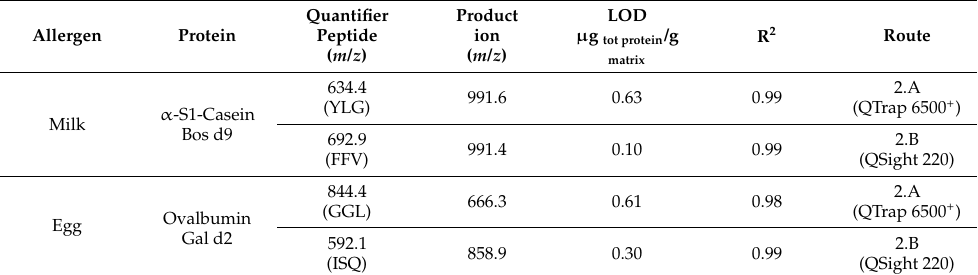
Table 3. Results of MRM experiments referred to matrix-matched calibration curves produced in fortified biscuits (route 2.A and route 2B) employing synthetic peptides for quantification (in route